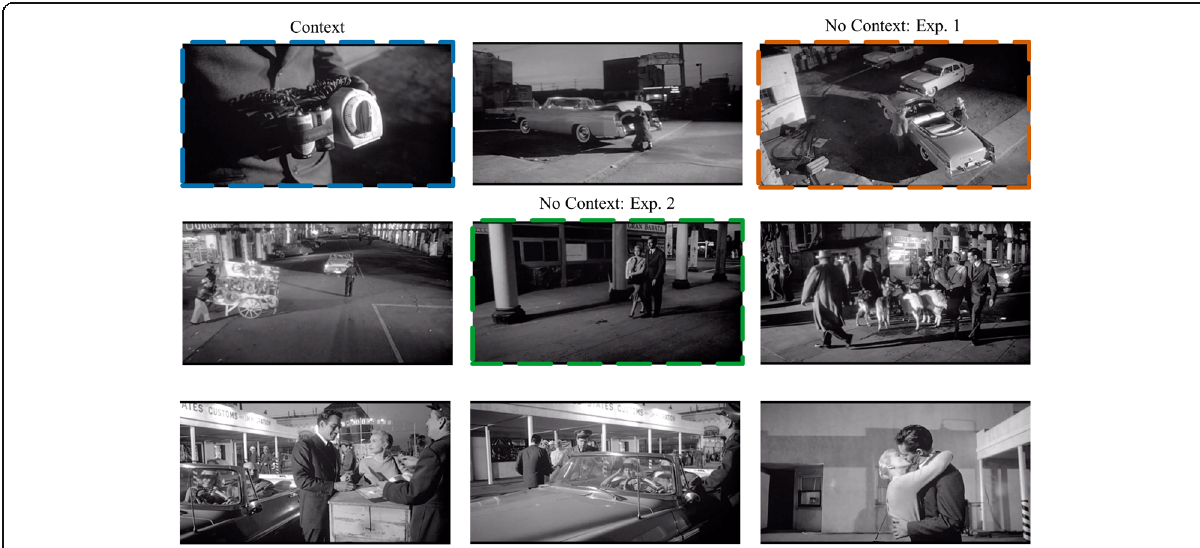
Fig. 1 Frames illustrating important shots in the 3 minute 12 second clip from the film Touch of Evil (Welles & Zugsmith, 1958). The blue box shows the Context condition (experiments 1 and 2), the orange box shows the No-context condition (experiment 1), and the green box shows the No-context condition (experiment